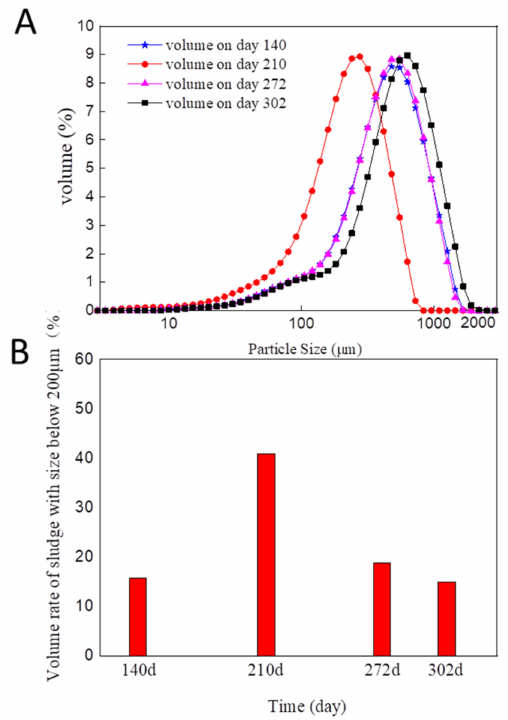
Figure 2. Size distribution of the aerobic granules during the long-term operation period: ( A ) Particle size distribution; ( B ) volume of sludge with size below 200 µ